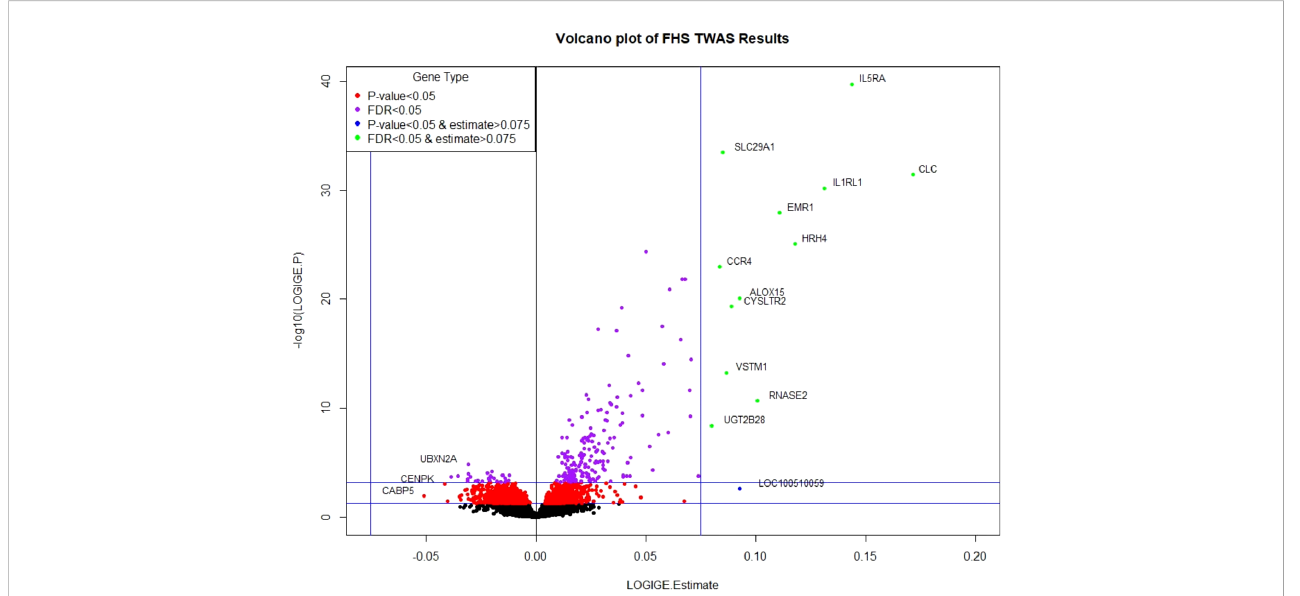
FIGURE 2 Volcano plot of FHS TWAS results. P-value <0.05 signi fi cance threshold is the lower line and P-value <6.09×10 -4 (which corresponds to an FDR<0.05) is the upper line.